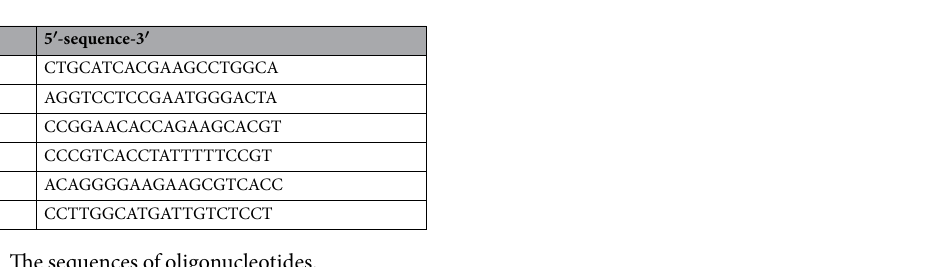
Table 1. The sequences of